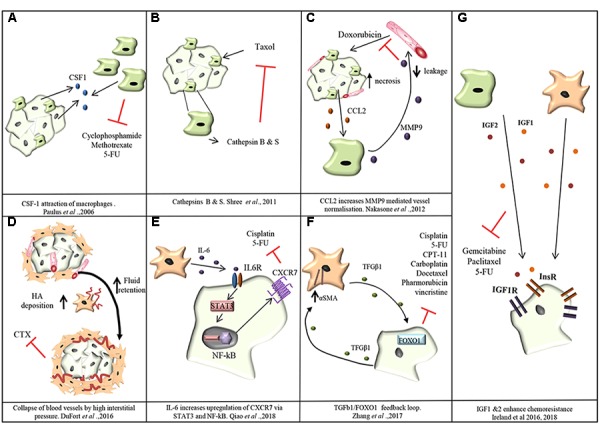
Mechanisms of chemoresistance mediated by TAMs and CAFs. (A) Cancer cells attract TAMs via CSF-1. TAMs confer resistance of MCF-7 breast cancer cells toward cyclophosphamide, methotrexate and 5-fluorouracil (5-FU; Paulus et al., 2006). (B) Cathepsins B and S secreted by TAMS mediate resistance of breast cancer cells to taxol in MMTV-PyMT mouse model (Shree et al., 2011). (C) In the MMTV-PyMT transgenic mouse model, cancer cell necrosis caused by doxorubicin treatment causes cancer cells to release the monocyte chemoattractant CCL2. Recruited TAMs produce MMP-9 which causes leakiness of blood vessels and reduction in doxorubicin delivery (Nakasone et al., 2012). (D) In PDAC, CAFs increase deposition of hyaluronan (HA) creating an increase in fluid retention and subsequently interstitial pressure in the tumor rises causing the collapse of blood vessels and limiting the delivery of chemotherapeutic agents (DuFort et al., 2016). (E) CAF secreted IL-6 stimulates the upregulation of CXCR7 through STAT3/NF-kB signaling promoting resistance of esophageal squamous cell carcinoma cells against cisplatin and 5-FU (Qiao et al., 2018). (F) CAF-derived TGF-β upregulates FOXO1 expression in esophageal squamous cell carcinoma cells triggering reciprocal TGF-β secretion which in turn increases the levels of αSMA expression in CAFs and resistance to cisplatin, taxol, irinotecan (CPT-11), 5-FU, carboplatin, docetaxel, pharmorubicin, and vincristine (Zhang et al., 2017). (G) TAM and CAF derived IGF-1 and IGF-2 activate insulin and IGF-1 receptor signaling on tumor cells conferring resistance of pancreatic and breast tumors to gemcitabine and paclitaxel (Ireland et al., 2016, 2018).